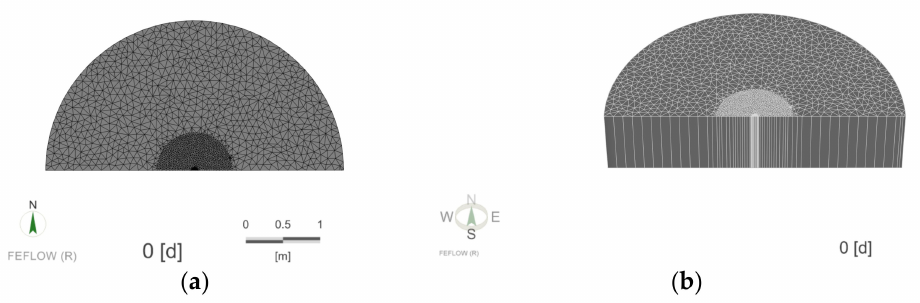
Figure 11. Numerical model diagram. ( a ) Mesh generation; ( b ) 3D model building.